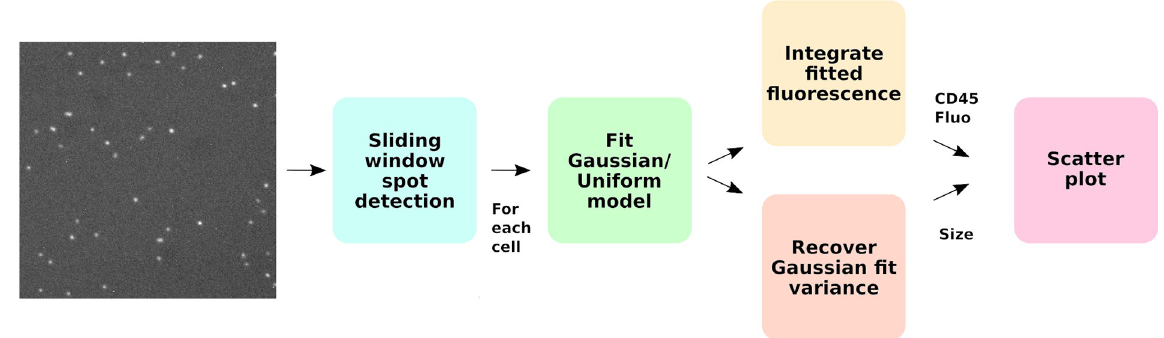
Fig 1. Graphical overview of the proposed approach. The method first detects bright spots using an LDA classifier, then, a model comprised of a gaussian and an uniform distribution is fitted to an image patch around each cell. Finally, the relative contribution of the gaussian and uniform distribution is used to compute the fluorescence intensity, while the variance of the gaussian distribution is used as a diameter estimate. These two features enable the creation of scatter plots similar to the ones resulting from flow cytometry